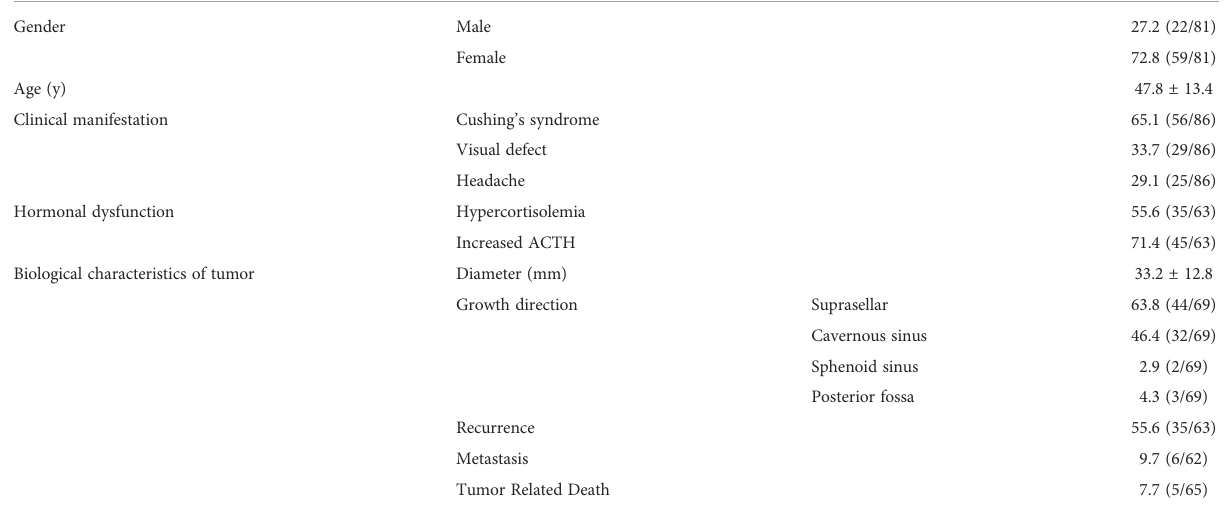
TABLE 4 Characteristics of Reported